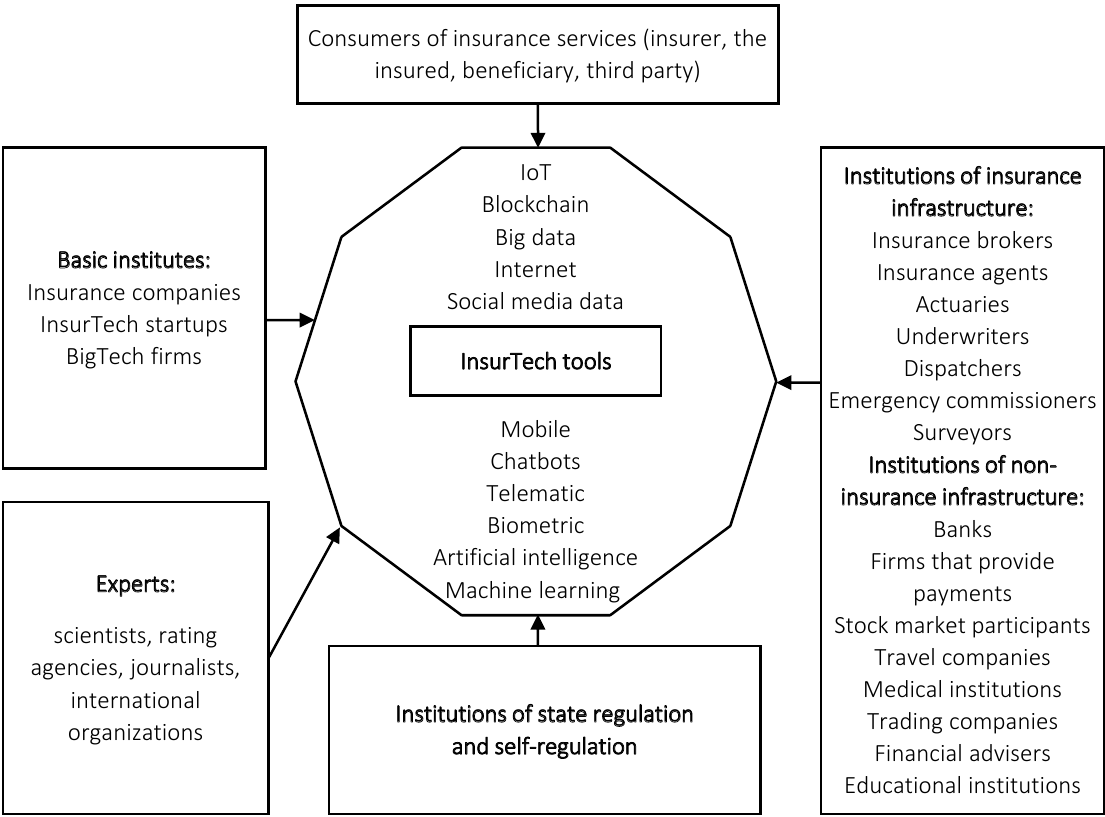
Figure 1. InsurTech